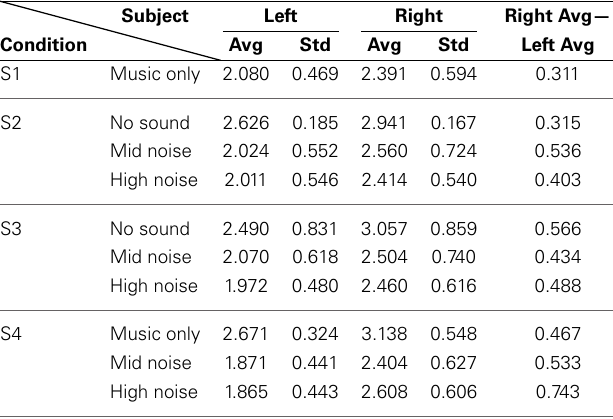
Table 4 | Average of only those cases where Right > Left from Table